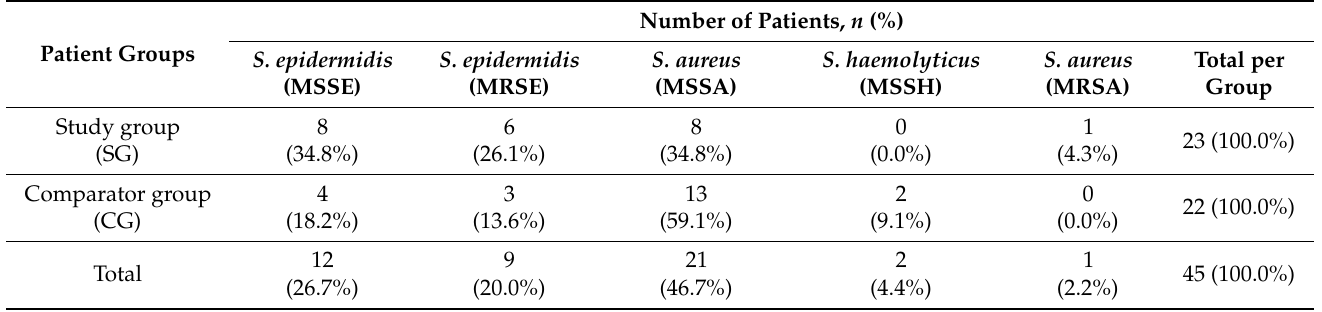
Table 2. Etiology of PJI in both groups (ITT population).